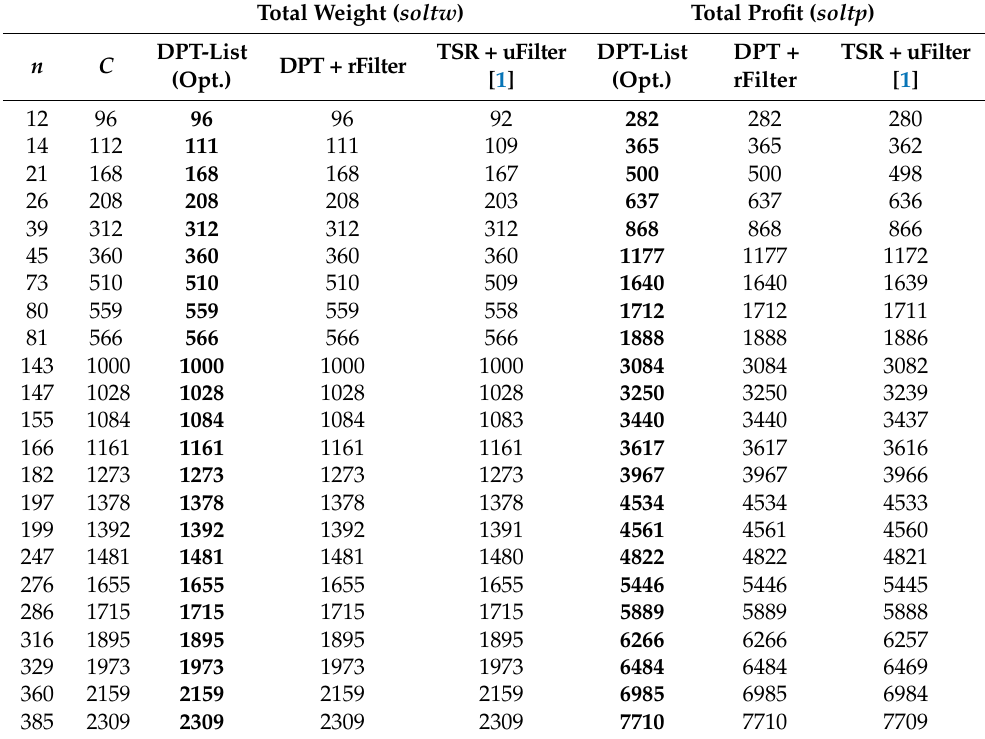
Table 2. Experimental results of irregular datasets (23 of 223), observed from n = 5, 6, 7, . . . , 10,000.